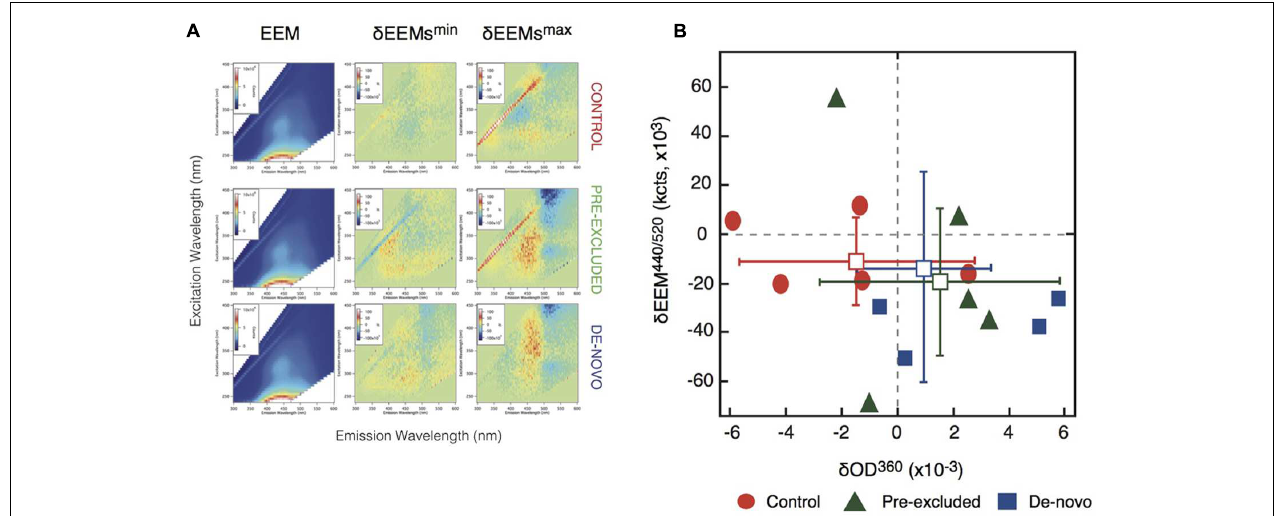
FIGURE 4 | Changes to carbon composition measured using Excitation-Emission matrix (EEM) spectroscopy. (A) Scatter plots representing the correlations between changes in the optical absorption and emission data. Vertical axis is the difference in the EEM region centered at λ ex = 440 nm and λ em = 520 nm (i.e., the blue regions in Figure 3A ). Horizontal axis is the difference in UV-vis absorption at 360 nm. (B) Excitation-emission matrix (EEM) analysis of control and excluded soils. Column 1 summarizes averaged EEM data for one replicate series of five extractions from each soil. Columns 2 and 3 report difference EEM ( δ EEM) data obtained by subtracting the averaged EEM from the control site from a selected individual EEM. Shown are the individual δ EEM data that exhibited the smallest (column 2) and largest (column 3) differences from the averaged control. In-figure inserts show pixel intensity values (Column 1 = × 10 6 ; Column 2 = × 10 3